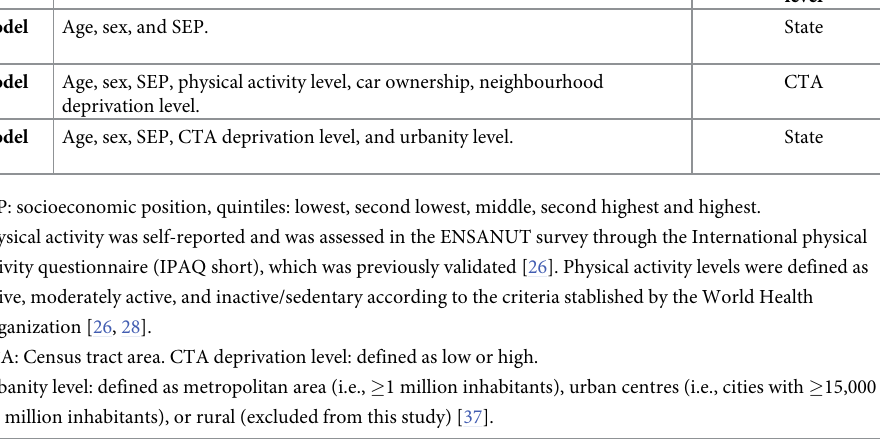
Table 1. Multilevel linear regression models used to test the association of food outlet density and dietary patterns.